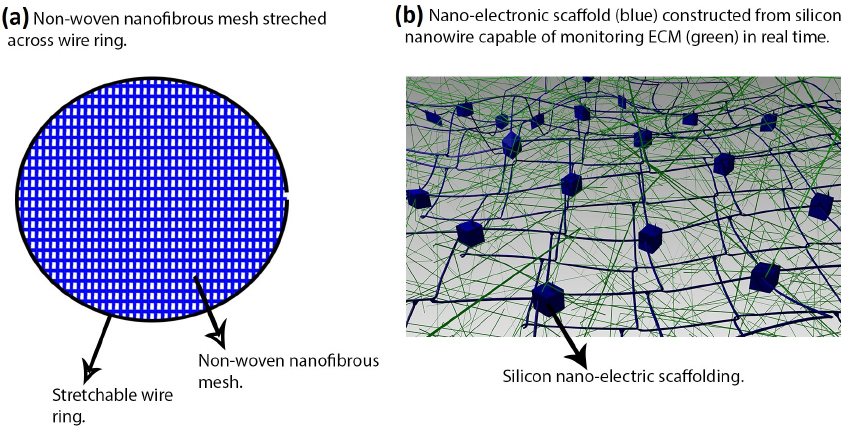
Figure 3. Two novel studies in cardiac tissue engineering: ( a ) electrospun polycaprolactone (PCL) nanofibrous mesh stretched across a wire ring used to create a passive load exerted by the wire allowing for cultured cardiomyocytes (CMs) to reach appropriate maturity prior to implantation [52]; ( b ) nanoelectronic scaffold (blue) constructed from silicon nanowire field effect transistors capable of real-time monitoring of local electrical activity within the extracellular matrix (ECM) (green)